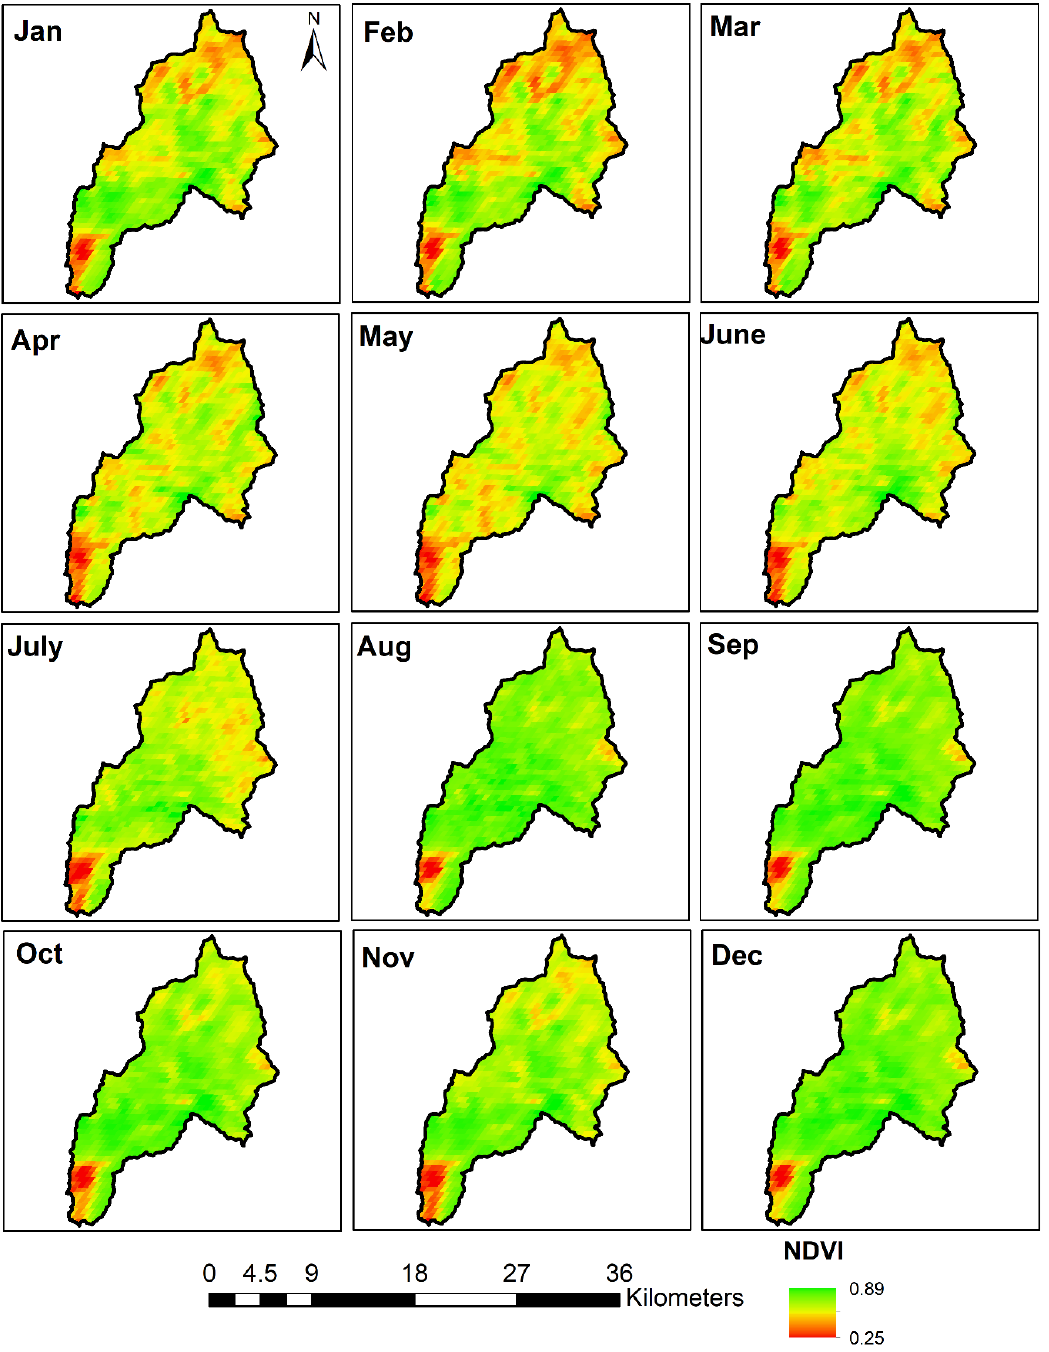
Figure 6. Mean monthly spatial variations of NDVI for the twenty-year period (2001–2020) for the UKR Basin.